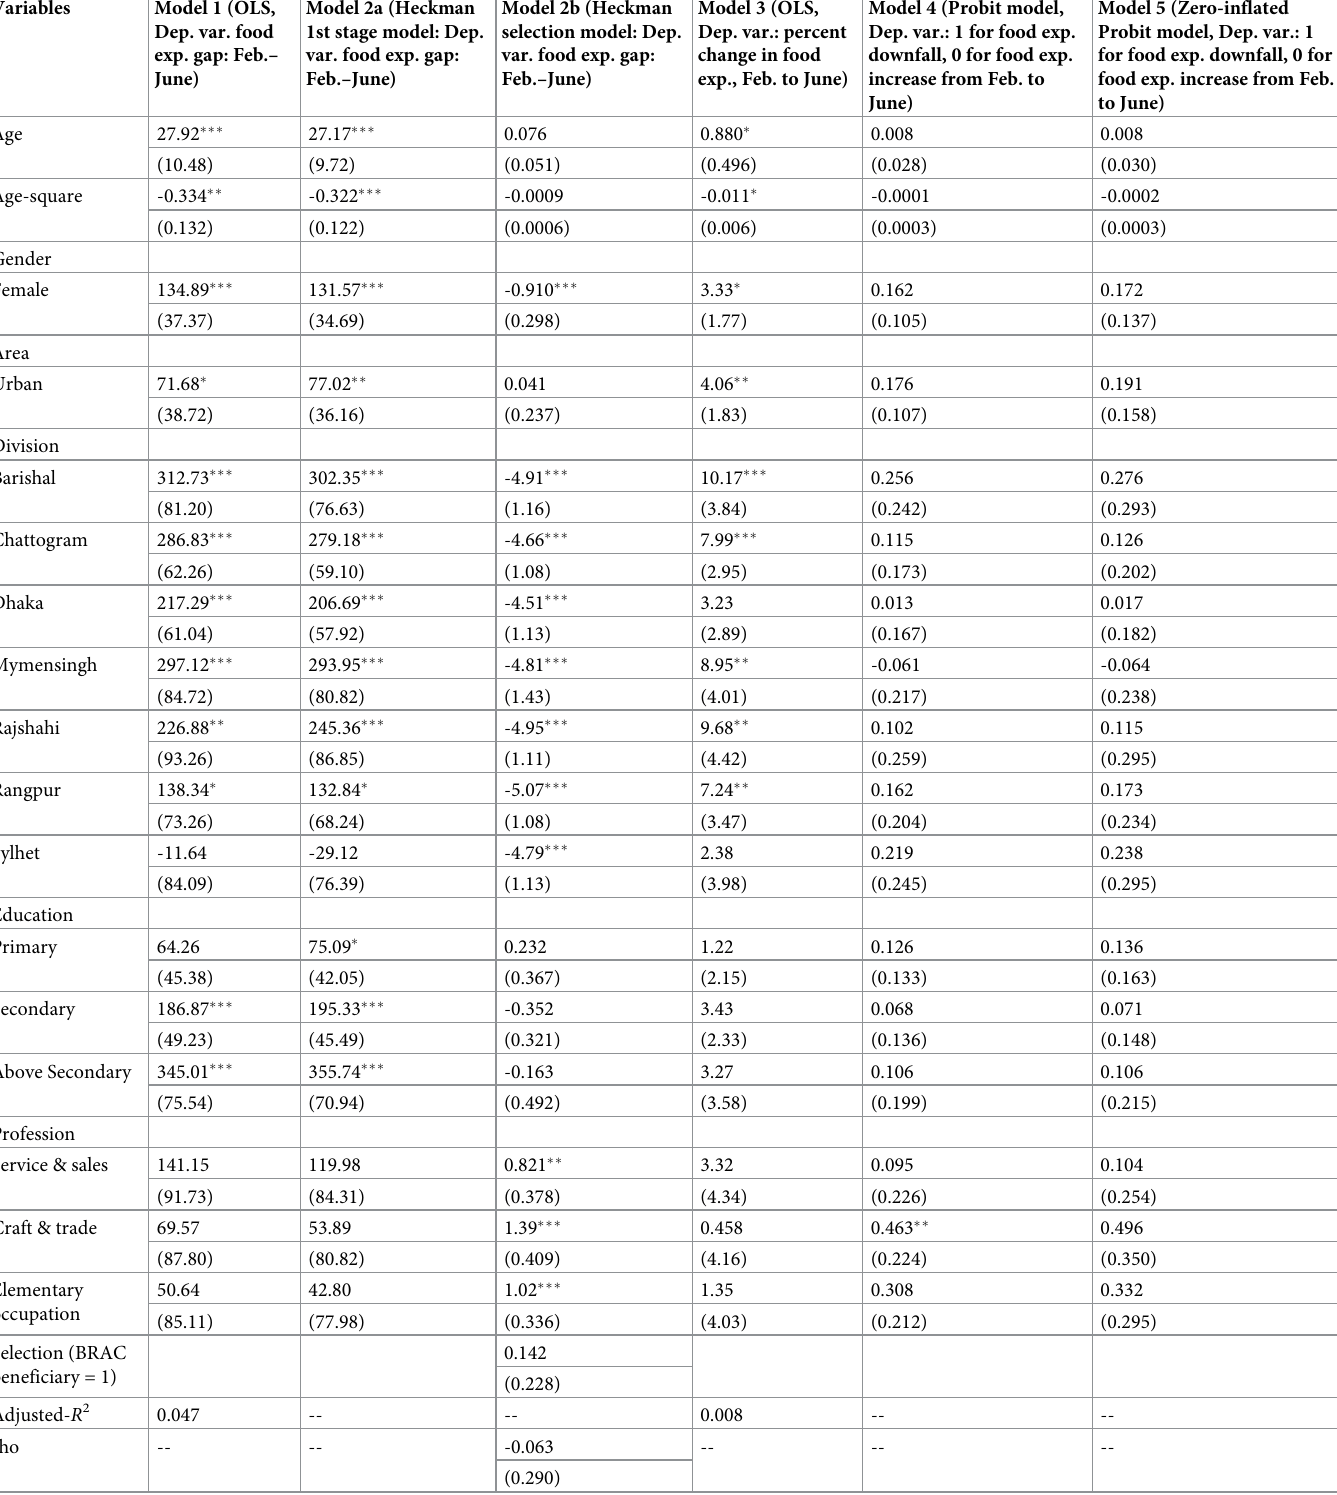
Table 7. Multivariate regression analysis and determinants of food expenditure downfall.